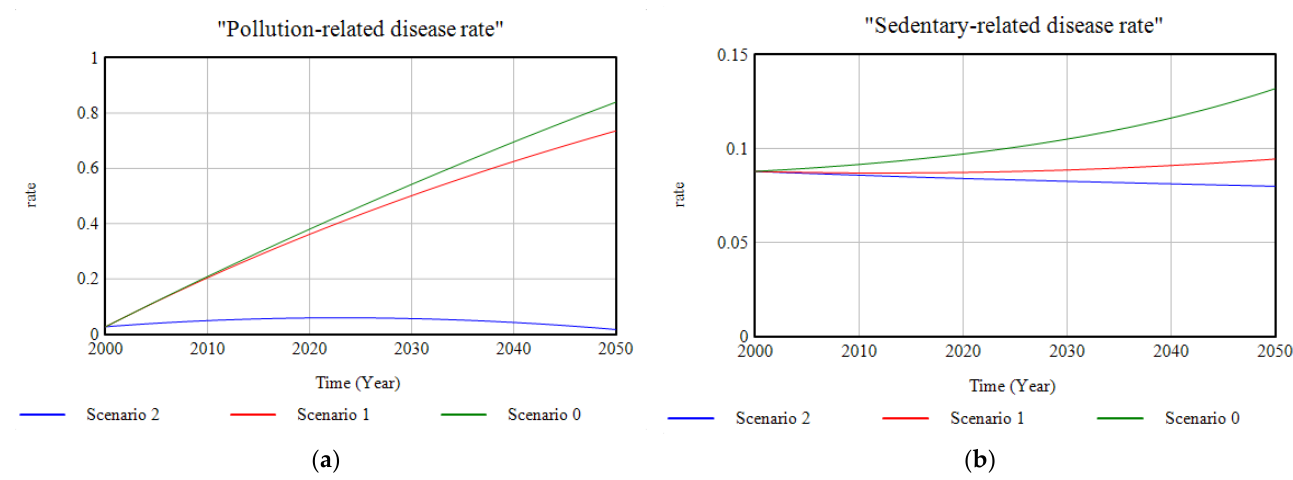
Figure 18. ( a ) Graphic representation of the progression of the pollution-related disease rate; ( b ) graphic representation of the sedentary-related disease rate for the three cases of study modelled, in the period 2000–2050.